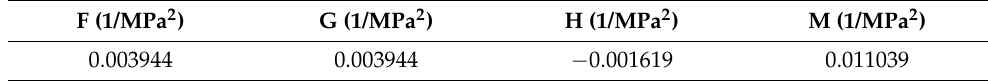
Table 4. Hill’s parameters derived from experimental